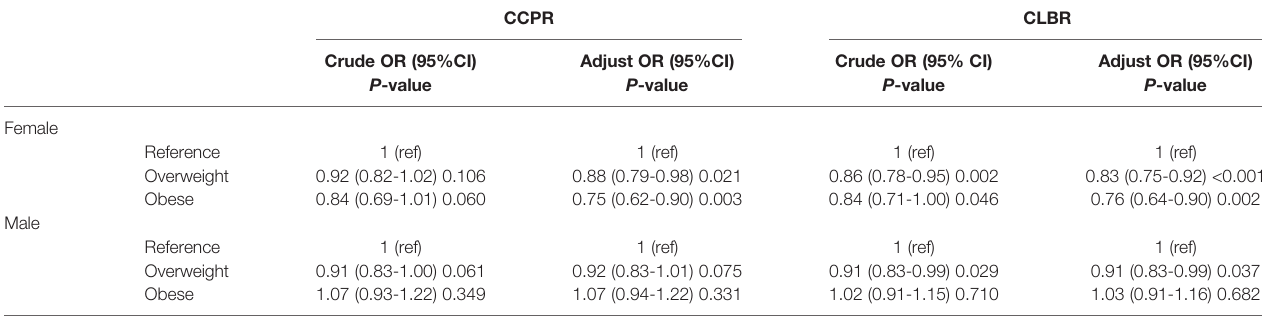
TABLE 3 | Results from logistic regression analyses of pregnancy outcomes in IVF/ICSI cycles according to sex and strati fi ed by body mass index (BMI).